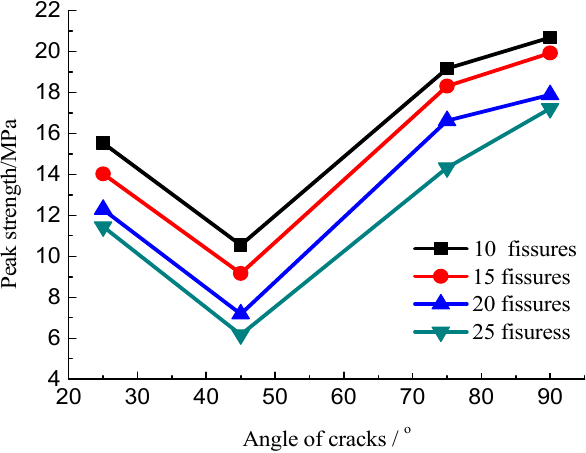
Figure 14. Relation curve of the peak stress with different number of cracks.